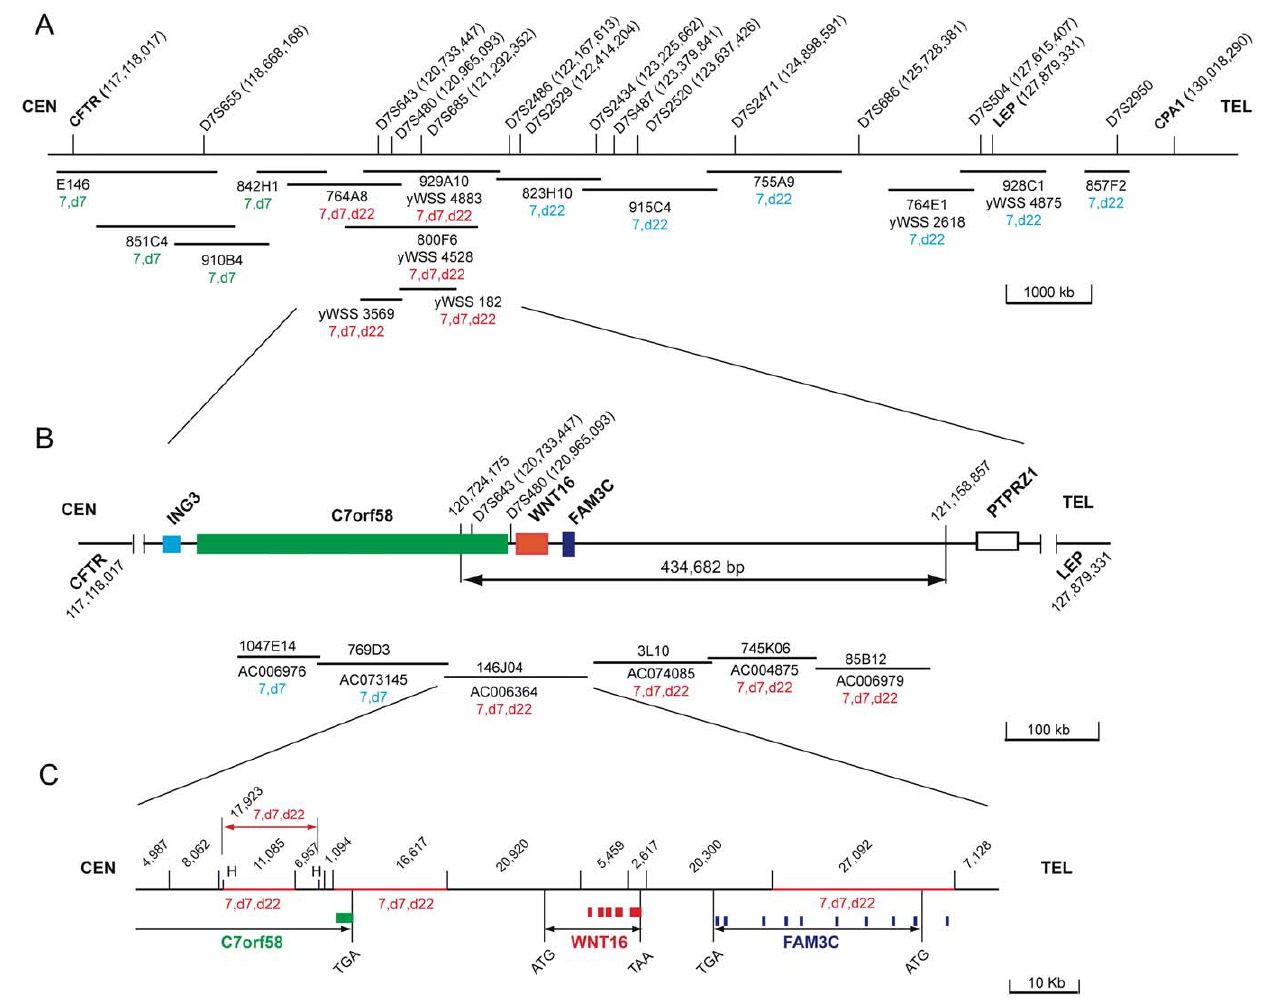
Figure 4. FISH maps of YAC and BAC DNA clones from chromosome 7q31.1 in and around the duplicated region. The hg19 genomic coordinates of each marker and gene are indicated next to its designated name. The centromeric (CEN) and telomeric (TEL) directions are specified for orientation on the chromosome. Clones are denoted by their clone names, plate coordinates or/and Genbank designations. Each clone or restriction fragment is also denoted by its hybridization onto the patient’s chromosomes 7, der(7) and/or der(22). ( A ) FISH map of a 12.9 Mb region of chromosome 7 extending from the CFTR to the CPA1 genes. The denoted YAC probes represent three distinct areas of hybridization relative to the chromosome 7 translocation breakpoint, namely distal (7, der22), at or around the breakpoint (7, der7, der22) and proximal to the breakpoint (7, der7). ( B ) FISH map of BAC clones at and proximal to the 434,682 bp duplicated region, spanning the tail end of C7orf58 and the entire WNT16 and FAM3C genes. Note that all BAC clones within the duplicated region map to 7,d7,d22. ( C ) Bam HI restriction map, except for two designated Hind III (H) sites, of BAC 146J04 showing the FISH mapping of Bam HI and Hind III restriction fragments, indicating hybridization to 7,der(7) and der(22). The sizes in bp of each restriction fragment are shown and the exons in each gene displayed with solid boxes. The initiation (ATG) and termination (TGA, TAA) codons denote the gene boundaries except for C7orf58, which is only spanned by its last exon and part of the adjacent intron.